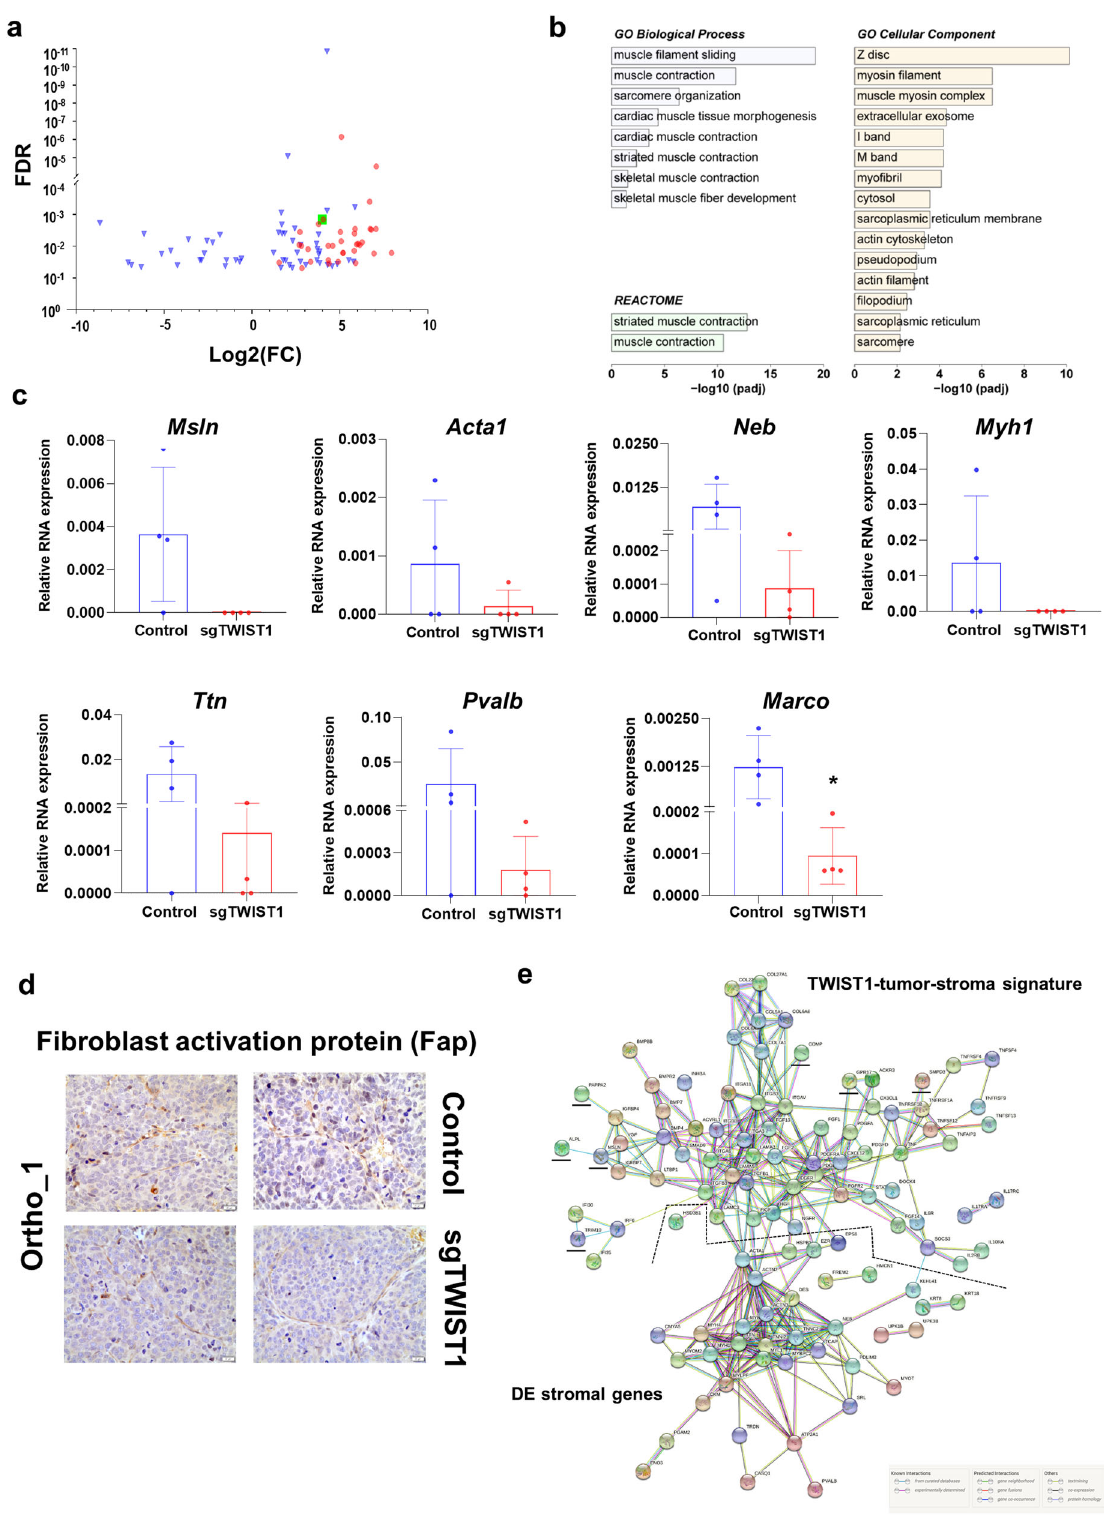
Statistics and reproducibility . All statistical analyses were performed using GraphPadPrism 8.3.0 (GraphPad Software Inc., San Diego, CA, USA). D ’ Agostino-Pearson normality test was performed for each data set, and depending on data distribution, they were analyzed with unpaired two-tailed parametric t-test or non-parametric Mann − Whitney test to compare two dif- ferent conditions or as indicated in the Figure legends. All in vitro tests were repeated independently at least three times with 2 − 5 technical replicates for